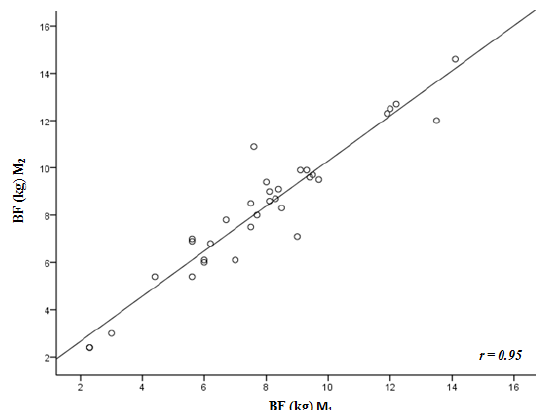
Figure 2. Correlation between the values of param- eters measured by Tanita before and after the intake of fluids – body fat (kg)